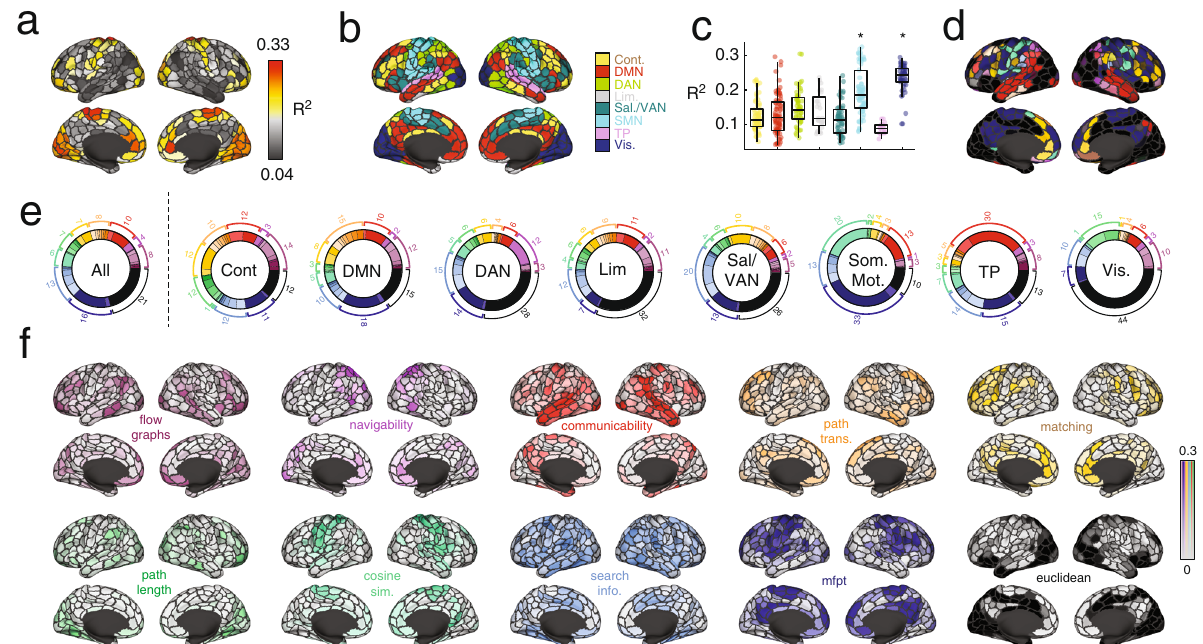
Fig. 3 Regional and system variation in local coupling patterns. a The maximum variance explained for each brain region by any of the factors. b Brain systems mapped onto cortical surface. c Maximum variance explained grouped by brain system. Each point represents a brain region ( N = 400 parcels de fi ned based on 40 ). In each boxplot, the “ box ” denotes interquartile range (IQR), the horizontal bar indicates the median value, and the whiskers include points that are within 1.5 × IQR of upper and lower bounds of the IQR (25th and 7th percentiles). Any points that fall beyond the whiskers are, by convention, considered outliers. d Surface projection of the factors that best explain each region ’ s FC pattern. e For each subject we calculated the most predictive factor for every brain region. Here, we group these factors at the level of the entire cerebral cortex ( All ) and at the level of individual systems. f For each region and factor, we calculated the fraction of subjects for which that factor explained the most variance. Here, we project these values to the cortical surface. Note here that the colors projected onto the surface are continuous; grays correspond to regions where a predictor was optimal for few subjects while brighter colors correspond to regions where a predictor was optimal for many subjects. In all panels the colorscale was capped at a value of 0.3. Note that the base colors for each surface plot correspond to different predictors and not varying levels of consistency across subjects or statistical signi fi cance. Source data are provided as a Source Data fi